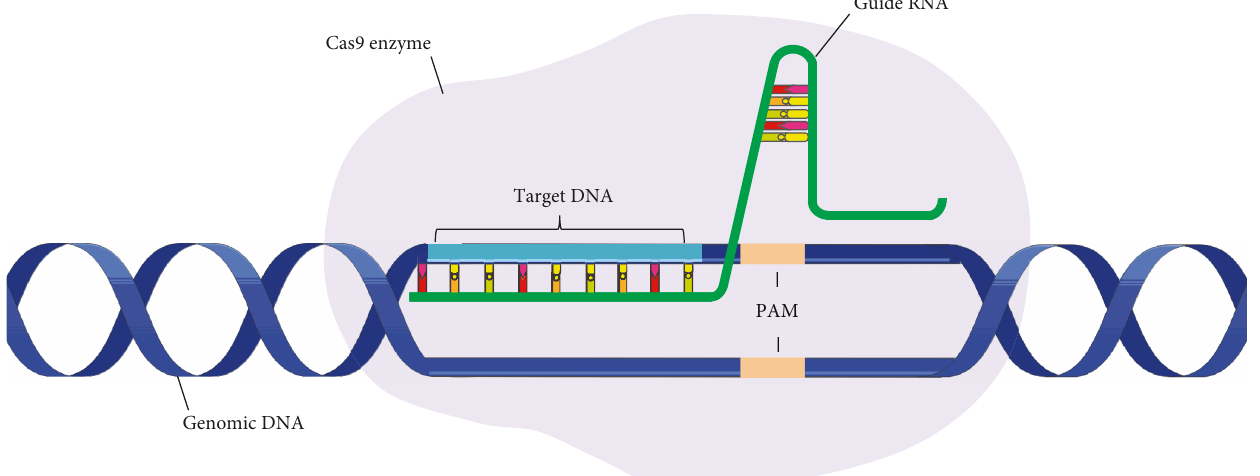
Figure 2: Principle of the CRISPR-Cas technology. A guide RNA (green) is composed of a crRNA sequence that is speci fi c to a target DNA (light-blue), linked to a tracrRNA sequence that interacts with Cas endonuclease. The complex recognizes the PAM sequence (protospacer adjacent motif), a trinucleotide immediately following the targeted DNA to orientate its cleavage. Genomic DNA is showed in dark